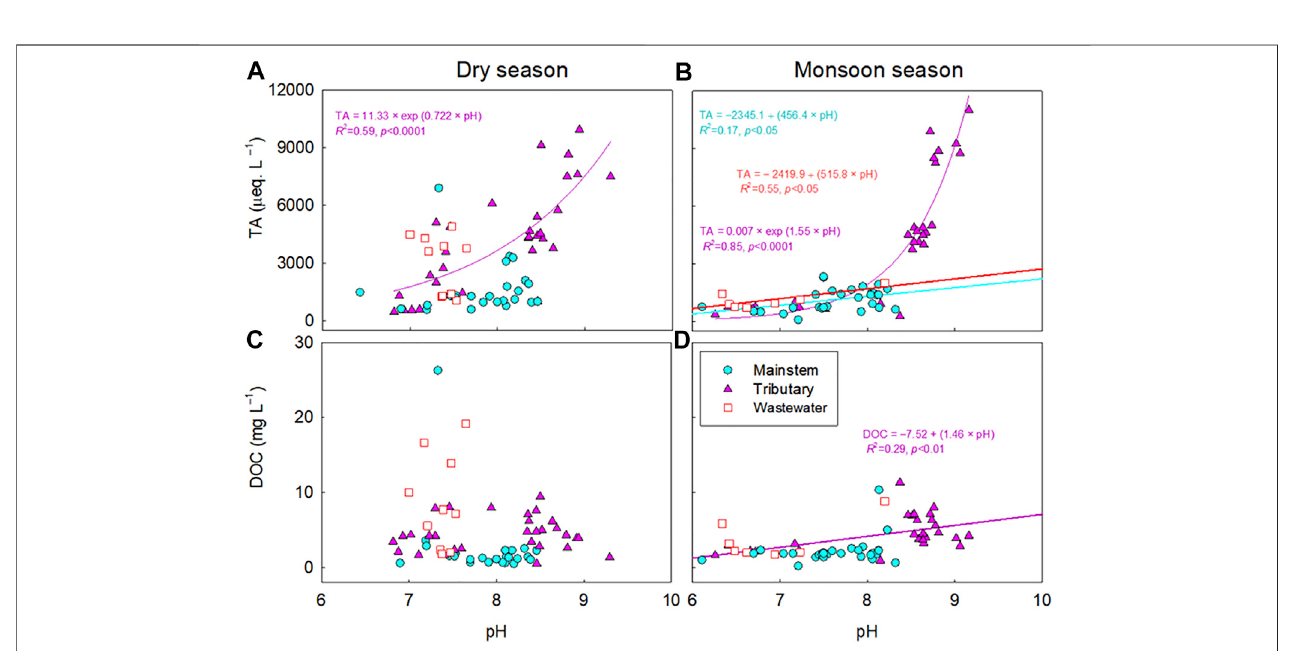
FIGURE 5 | Relationships between pH and total alkalinity (TA) (A,B) or dissolved organic carbon (DOC) (C,D) in the mainstems (M), tributaries (T), and polluted urban tributaries or wastewater ef fl uents (W) of the Ganges, Mekong, Yangtze, and Yellow River. The signi fi cant relationship ( p < 0.05) for each water type during the monsoon or dry season is indicated by a regression line through the plot.